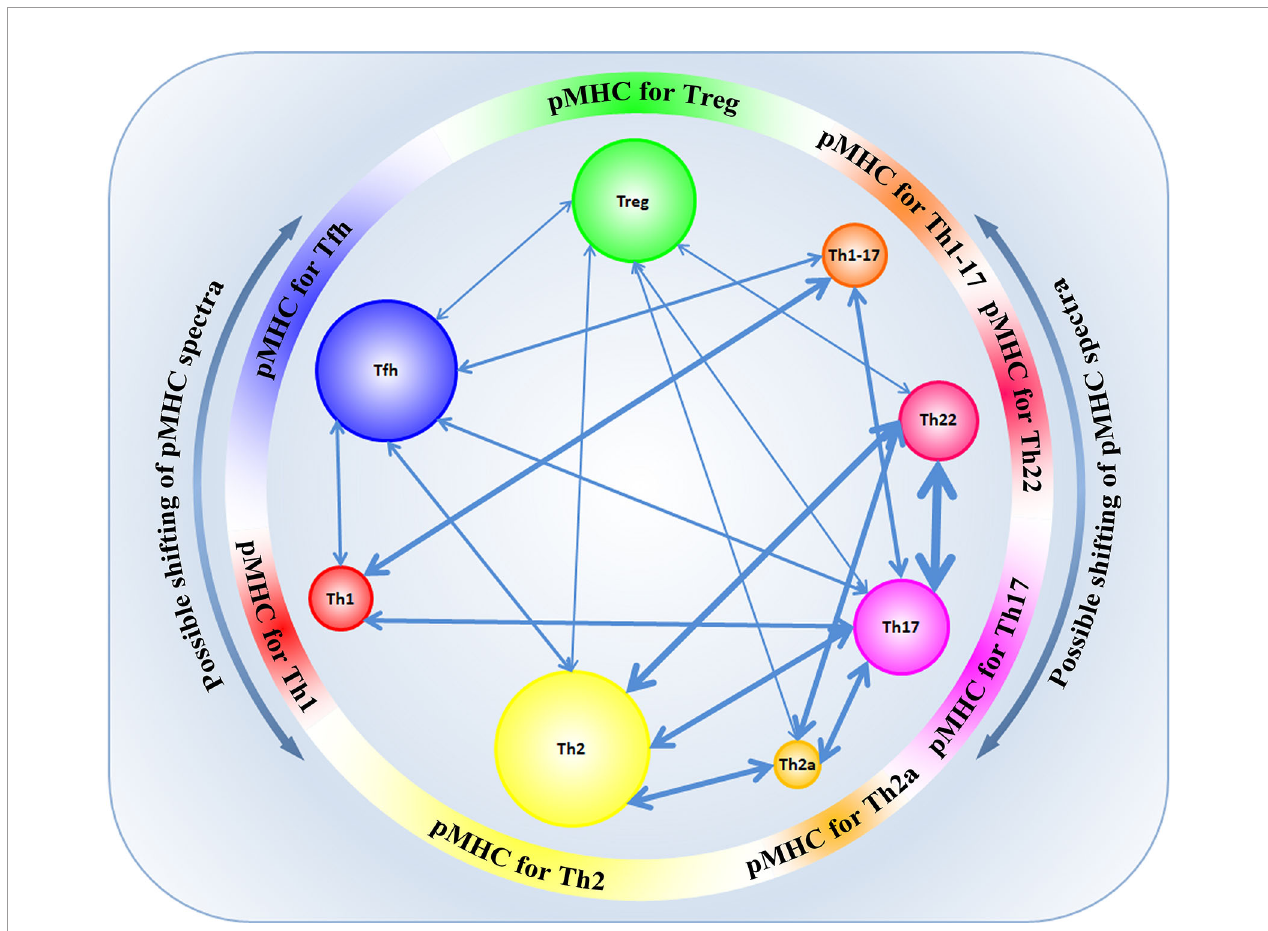
FIGURE 3 | The landscape of presentation shapes different CD4 + subpopulations according to their CDR3 physicochemical properties and speci fi city. Possible shifts in pMHC spectra can contribute to transdifferentiation between some subpopulations of CD4 + T cells. The width of the arrows re fl ects the number of common TCR clonotypes between